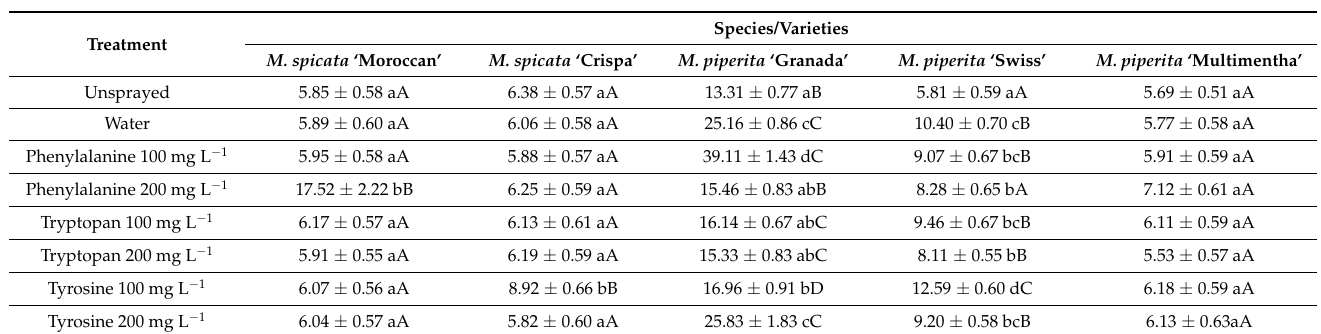
Table 4. Myricetin content in mint influenced by foliar application of amino acids, mg 100 g − 1 DM in